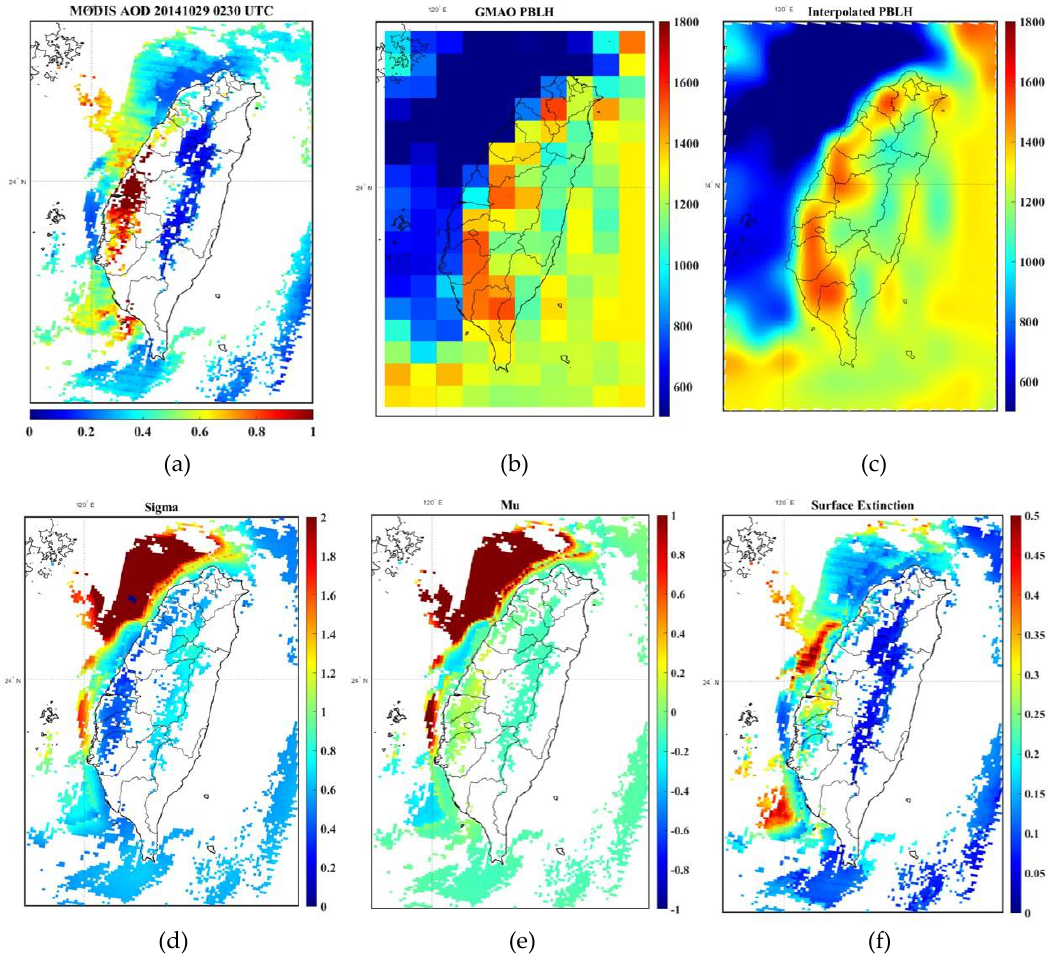
Figure 11. Procedure used to apply the proposed log-normal fitting method to the dataset on October 29, 2014, at 10:30 local time (LT). ( a ) Spatial distributions of the acquired MODIS AOD. ( b ) Spatial distributions of the acquired GEOS-5 FP PBLH products in meters. ( c ) Spatial distributions of the GEOS-5 FP products spatially interpolated to a MODIS AOD 3-km spatial resolution. The values were calibrated by the ratio with the MPLNET PBLH product in meters. ( d ) Logarithmic σ distribution map. ( e ) Logarithmic μ distribution map. ( f ) Distribution map of extinction coefficients below 500 m.